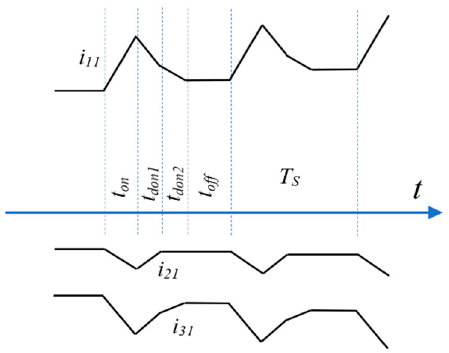
Figure 5. Input currents on L 1 in a few switching periods.